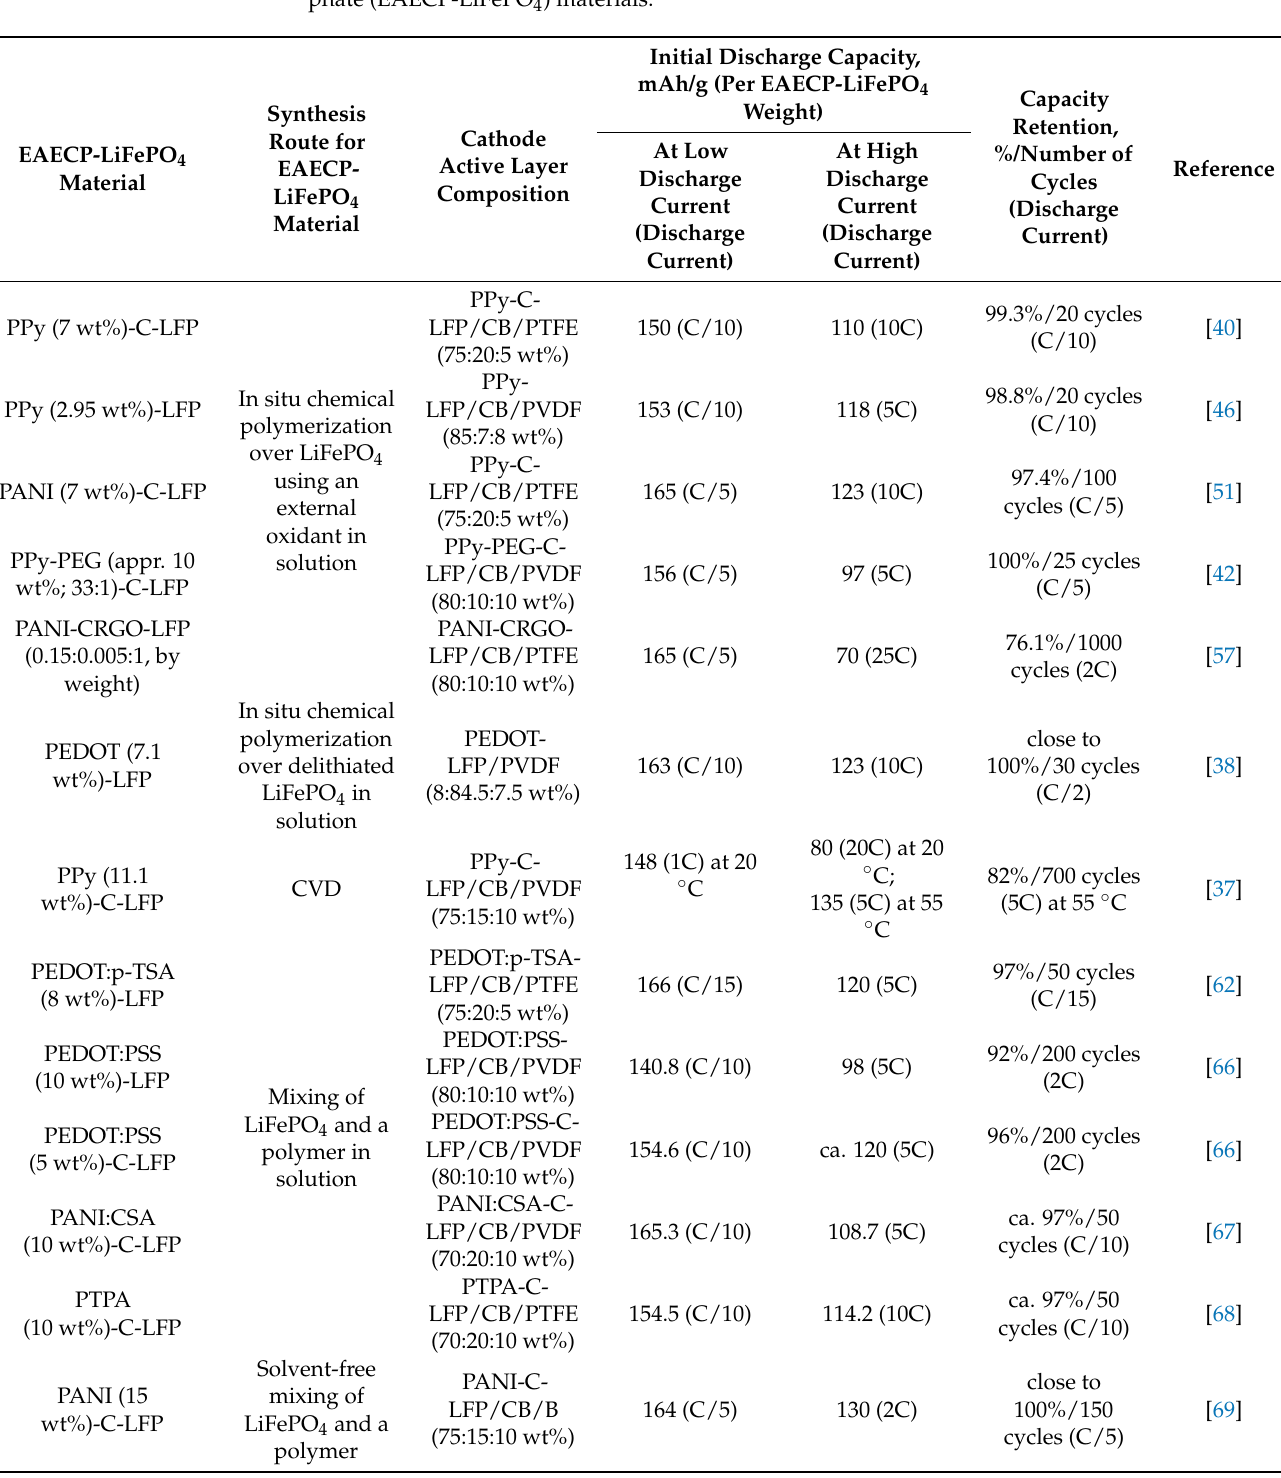
Table 2. Synthetic strategies and electrochemical performance of polymer-coated lithium iron phos- phate (EAECP-LiFePO 4 )